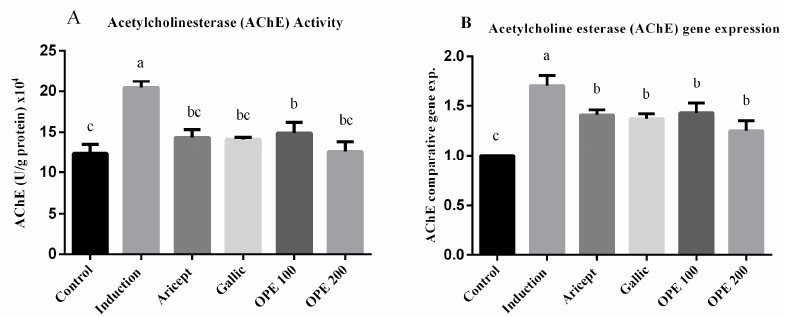
Figure 3. Effect of Aricept, gallic, OPE treatment on brain AChE activity ( A ) and gene expression levels (hypothalamus) ( B ). Values represent the mean ± SD of six rats. ANOVA (one-way) followed by Tukey’s test. Values bearing the same letters showed no significant difference ( p < 0.05). The results are sorted in descending order: a < b <